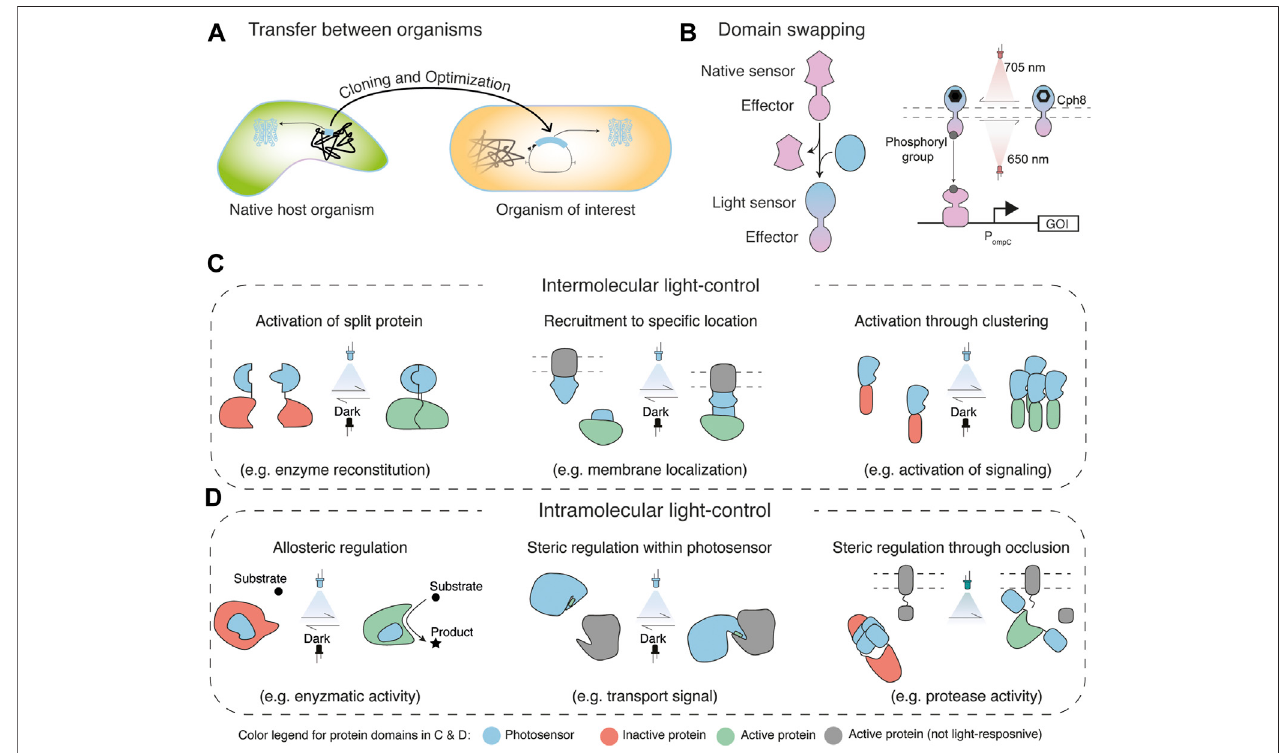
FIGURE 2 | Engineering strategies for light regulation (A) Transfer of light-sensing regulators and circuits from native host organisms into an organism of interest requirescompatibilityoftherespectivefunctionandoptimizationforthenewhost (B) Changeofthenativesensingfunctionofaproteintosensingoflightthroughdomain swapping (left), which was shown for the transformation of an osmoregulation bacterial two-component system (TCS) to a synthetic light-regulatable TCS (Levskaya et al., 2005). An intuitive way to categorize strategies for the creation of novel Opto-proteins is into intermolecular (C) and intramolecular light-control (D) (Baumschlager and Khammash 2021). Intermolecular light-control functions through proximity and distance of proteins. Thus, it usually comprises two or more interactingproteins,whosebinding/distancecanberegulatedwithlight.Suchregulationcanbeachievedthroughthereconstitutionofinactiveproteindomains(e.g.split fragmentsinOpto-T7RNAP(Baumschlageretal.,2017); (C) ,left),therecruitmentofanactiveproteintoalocationwhereitexertsfunction(e.g.membranelocalizationfor controlofphosphoinositide3-kinaseactivity (Toettcher etal.,2011); (C) ,middle),oractivationofacellularfunctionthroughclustering(e.g.activationofcellsignalingwith optoWnt (Rosenbloom et al., 2020); (C) , right). In contrast, intramolecular control involves the development of asingle protein chimera that comprises a light-responsive and an effector function. Regulation can be achieved allosterically in which light absorption leads to a structural change in the protein that changes the activity of the effector domain (e.g. enzymatic activity in yeast isocitrate dehydrogenase (Chen et al., 2021); (D) , left), steric blocking/unblocking of the function of the effector (e.g. exposureofatransport signal in thelight-induciblenuclearexport system(LEXY) (Niopek et al.,2016); (D) , middle), or steric regulation through occlusion (e.g. active site blocking of a protease (Zhou et al., 2012); (D) ,